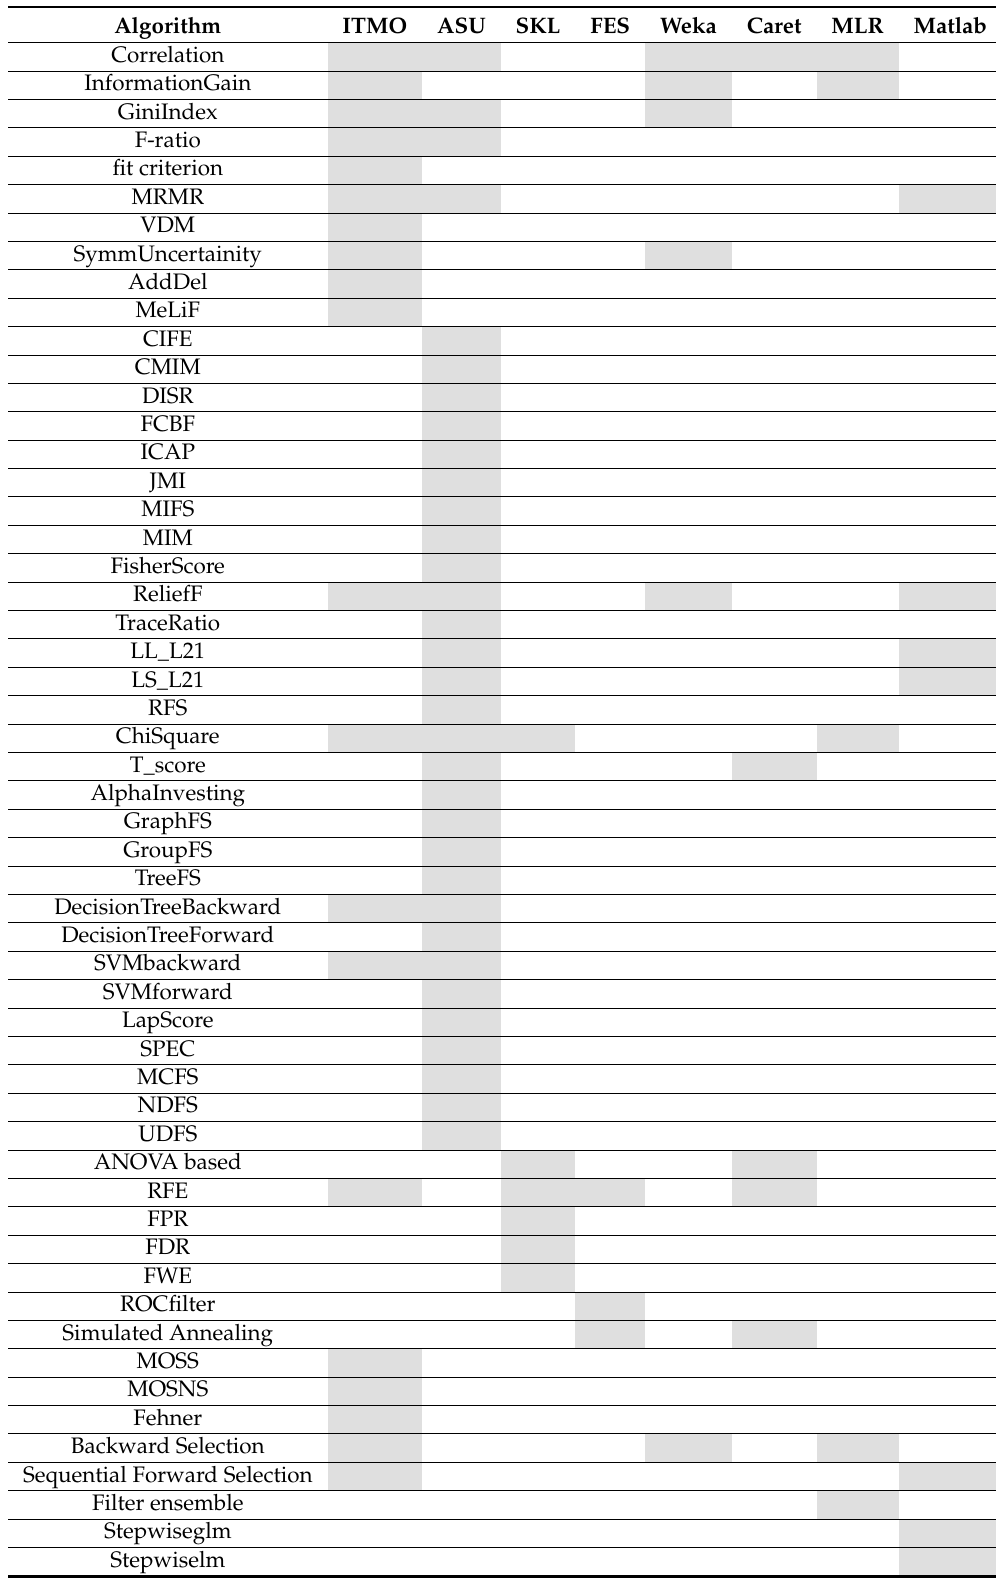
Table 1. Comparison of different Python FS libraries contents. Shaded box means that the algorithm is implemented in the corresponding library. ITMO stands for ITMO FS library presented in this paper, ASU for Arizona State University library, SKL for scikit-learn library, FES for FES book support code and MLR for mlr3